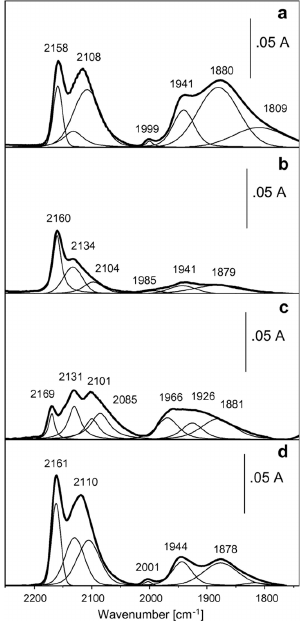
Figure 20. FTIR spectra of CO adsorbed at 180 K on Pd ( a ), 1Au2Pd ( b ), 1Pd2Au ( c ), and PdAu ( d ) after pre-treatment in H 2 and O 2 at r.t. (bold curves) and relative deconvolutions (fine curves). Reprinted from J. Catal., 268, F. Menegazzo, M. Signoretto, M. Manzoli, F. Boccuzzi, G. Cruciani, F. Pinna, G. Strukul, Influence of the preparation method on the morphological and composition 819